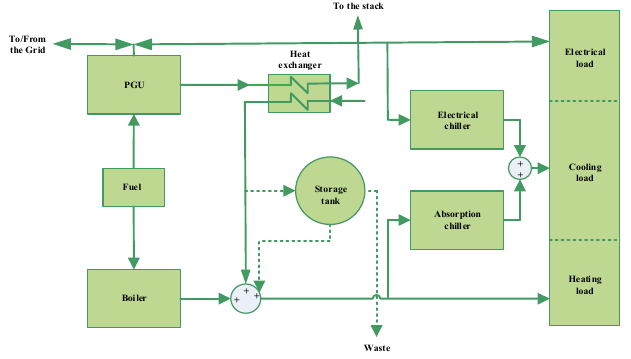
Fig. 1. Schematic of a CCHP system (Sanaye & Hajabdollahi,